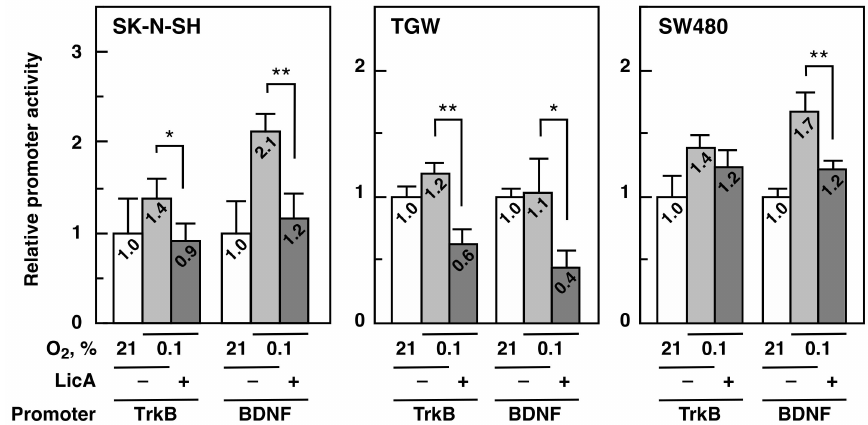
Figure 4. Reporter gene assay for TrkB and BDNF . The indicated cell lines were transfected with reporter plasmids covering the regulatory regions of the TrkB and BDNF genes. After 24 h, cells were cultured further in normoxia (open bars) and in hypoxia (0.1% O 2 ) without (light-shaded bars) or with 20 µ M LicA (dark-shaded bars). After 6 h, the cells were harvested, and luciferase activity was measured. * p < 0.05, ** p <